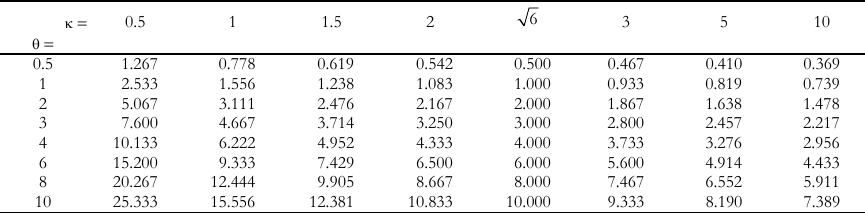
Expected value of TF distribution for some parameter